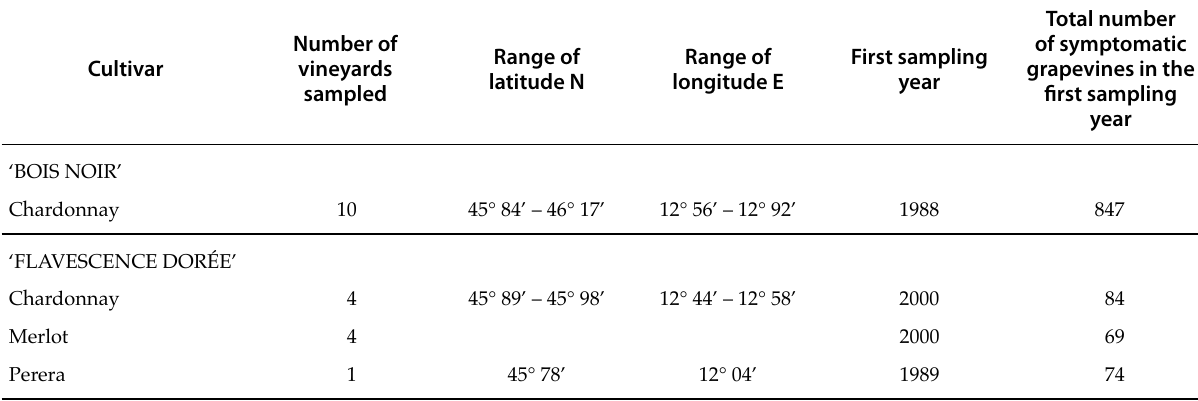
Table 1. Number of vineyards sampled for phytoplasma type and cultivar, their spatial localization and number of grape - vines checked for symptom expression over the sampling